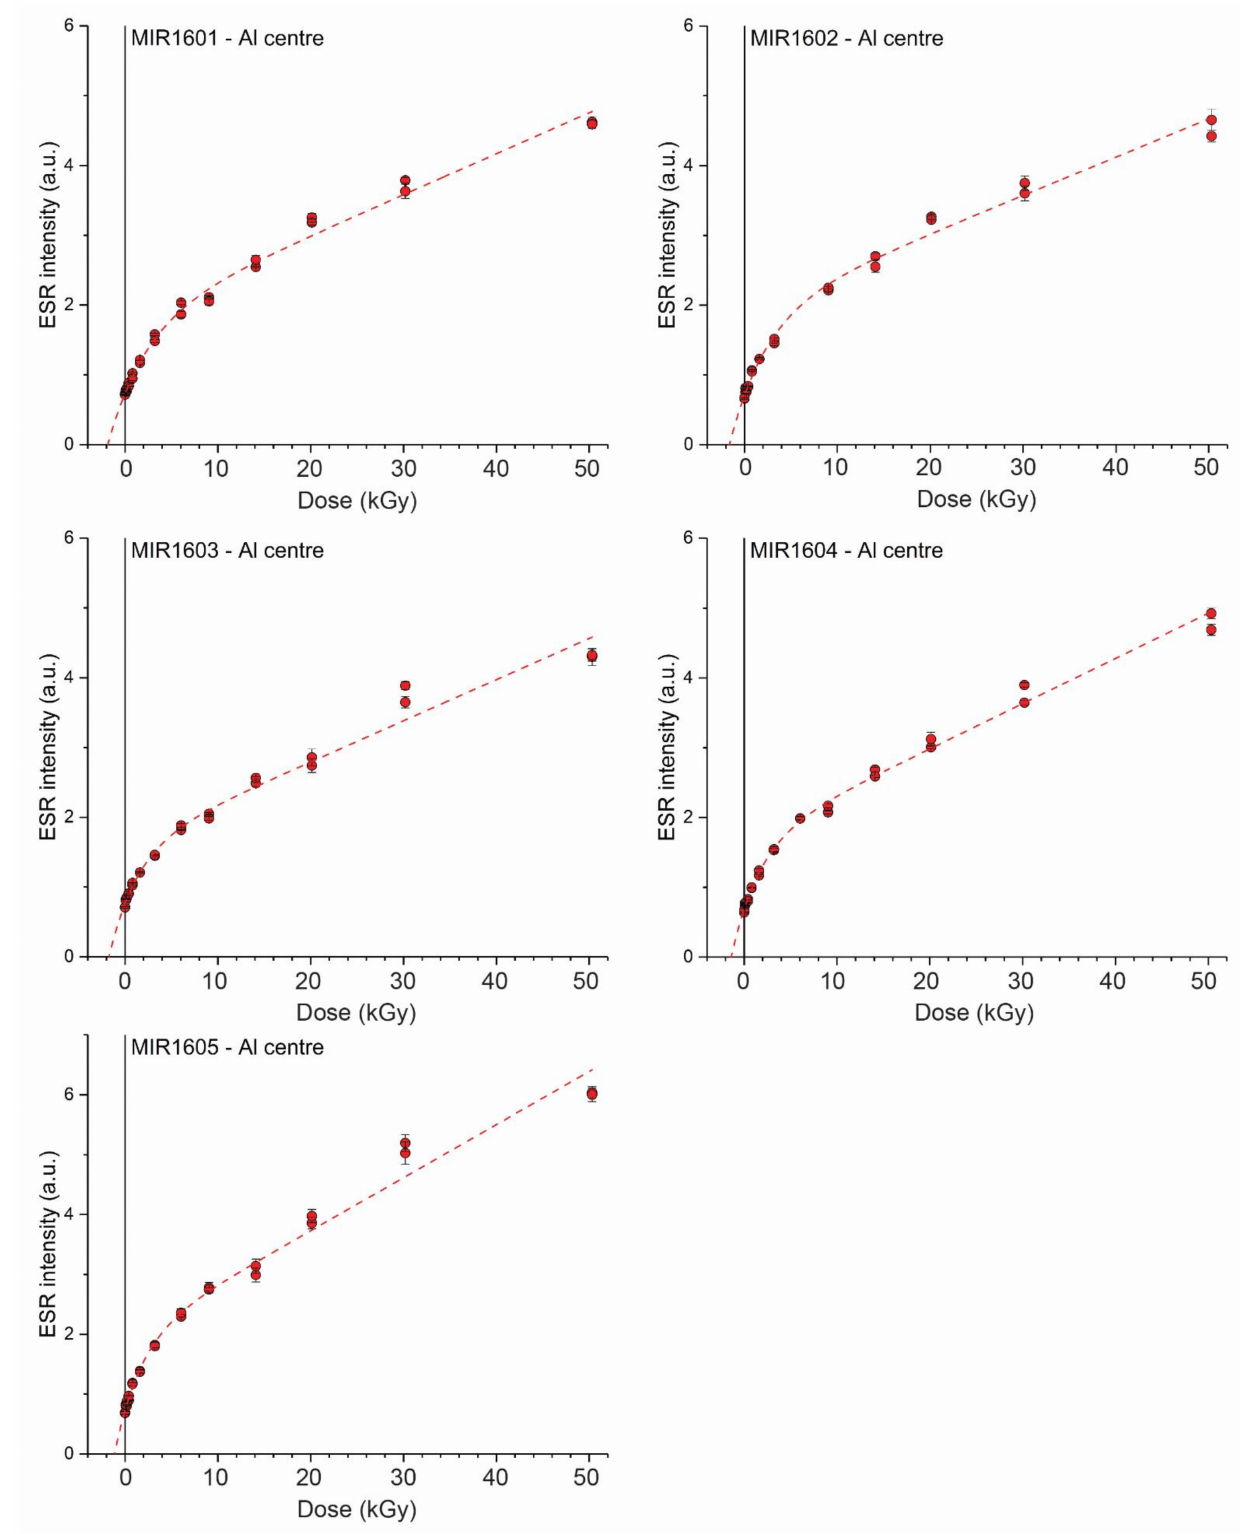
Figure 3. ESR dose response curves (DRCs) of the Al center obtained for five samples dated in present work. All ESR intensities derived from repeated ESR measurements were pooled for fitting. Vertical error bars represent experimental errors associated with ESR intensities, corresponding to 1 standard